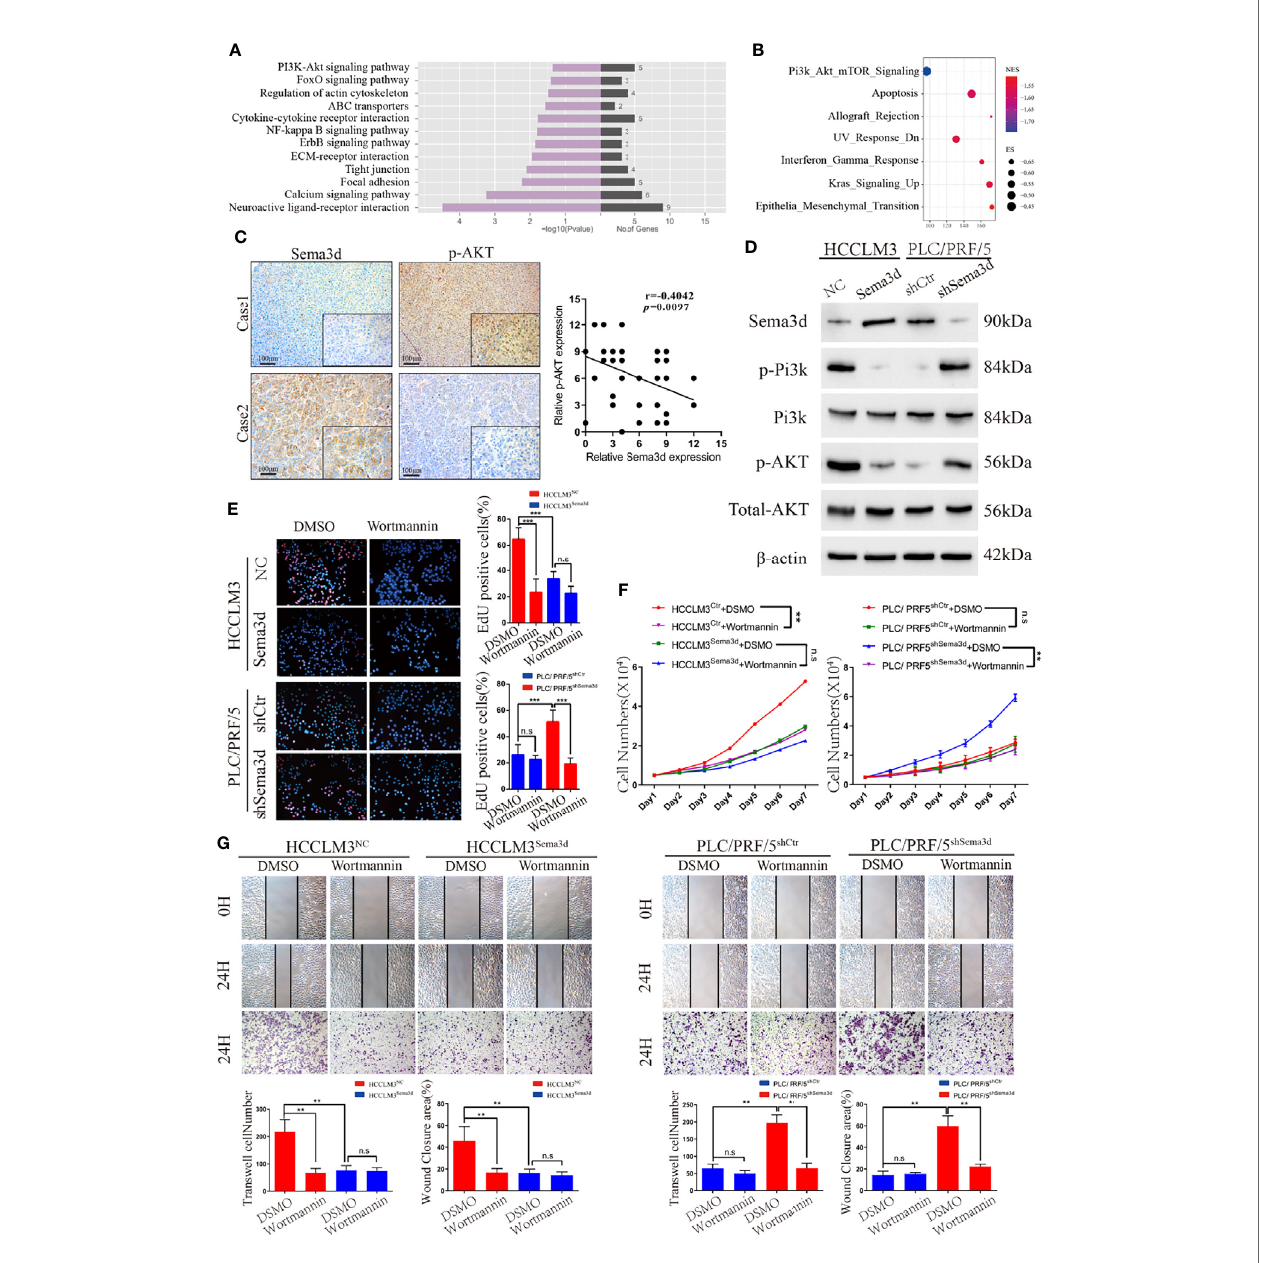
FIGURE 4 | Sema3d restrains HCC progression via inactivating Pi3k/Akt signaling. (A) RNA-seq and KEGG analysis of HCCLM3 Sema3d cells compared with HCCLM3 NC cells revealed the potential signaling pathway regulated by Sema3d in HCC cells. (B) GSEA was performed between the Sema3d high- and low- expression patients in TCGA dataset. (C) Representative IHC images of Sema3d and p-AKT and their expression correlations were analyzed by Spearman ’ s rank correlation tests in 40 HCC tissue samples. (D) Expression of Pi3k and Akt and their phosphorylation level in Sema3d-interfered HCC cells were detected by Western blot. (E) EdU staining assay detected the proliferation for Sema3d-interfered HCC cells with/without Wortmannin treatment. (F) MTT assay detected the proliferation of ema3d-interfered HCC cells, and their control cells with/without Wortmannin treatment. (G) Wound healing and Transwell invasion assays detected the migration and invasion of Sema3d-interfered HCC cells with/without Wortmannin treatment. ** p < 0.01; *** p < 0.001. n.s, no signi fi